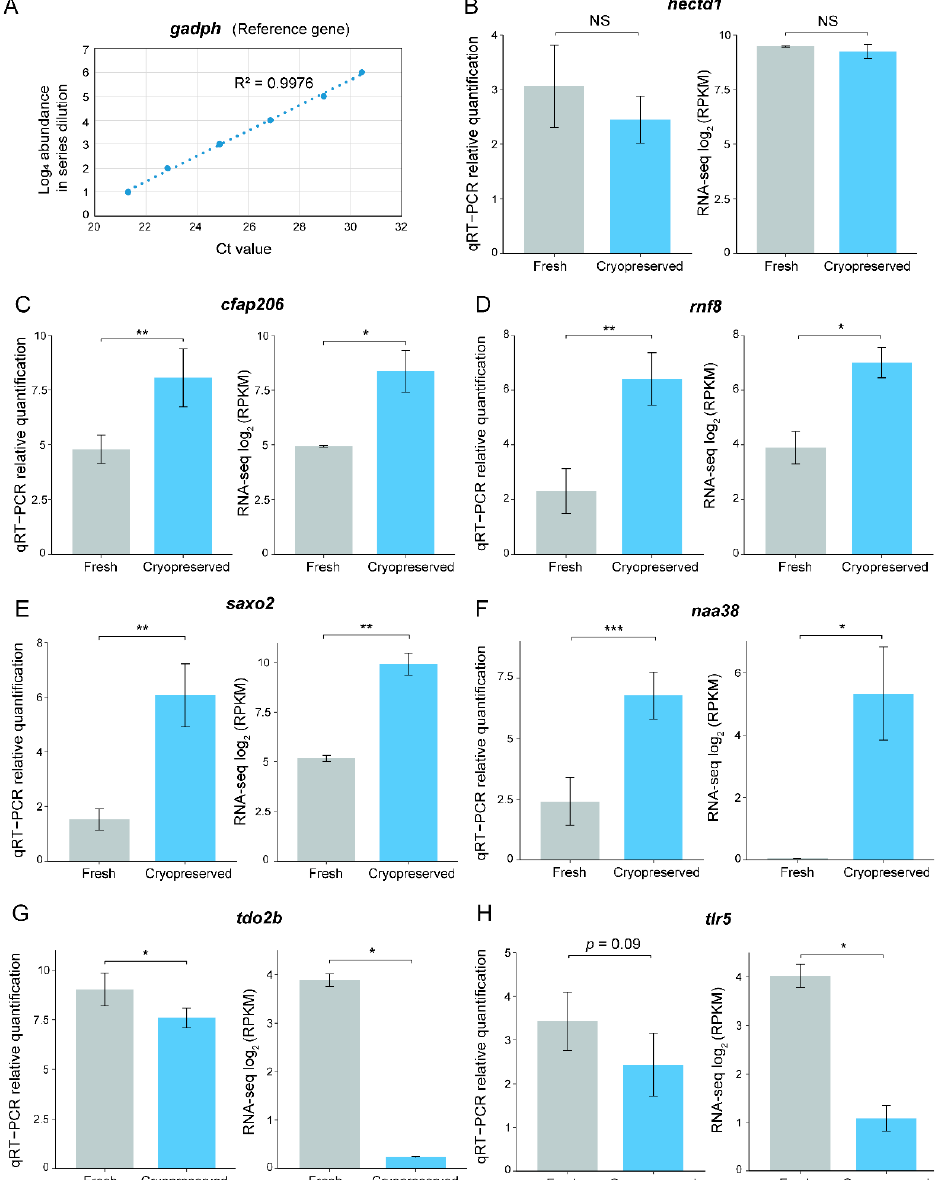
Figure 3. Quantitative reverse transcription PCR validation of differentially expressed genes (DEGs) in fresh-frozen and cryopreserved sperm in the blue catfish, Ictalurus furcatus . ( A ) Scatterplot of the standard curve based on a series of dilutions for the reference gene gapdh . ( B – H ) Barplots of qRT-PCR relative quantification ( left ) and log 2 RNA-seq RPKM values ( right ) for hectd1 ( B ), cfap206 ( C ), rnf8 ( D ), saxo2 ( E ), naa38 ( F ), tdo2b ( G ), and tlr5 ( H ). Student’s t -test was used to assess the statistical significance (* p < 0.05; ** p < 0.01; *** p <